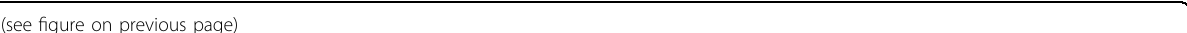
Fig. 1 Overview of the genetic alterations identi fi ed in 102 T-ALL patients. a Single-nucleotide variations, small indels, and copy number alterations are presented for the 31 most frequently altered genes. Cases have been grouped by the presence or absence of a CDKN2B deletion, followed by cases with copy number alterations of genes on 9p21.3 ( CDKN2A , MTAP , and MLLT3 genes). The patient cohort is further annotated according to the ETP status, gender, and age groups. Each column represents one patient, and each colored box indicates a mutation. b Each colored box represents each genetic alteration (copy number alterations, single-nucleotide variations, and small indels) per gene. Each column corresponds to one